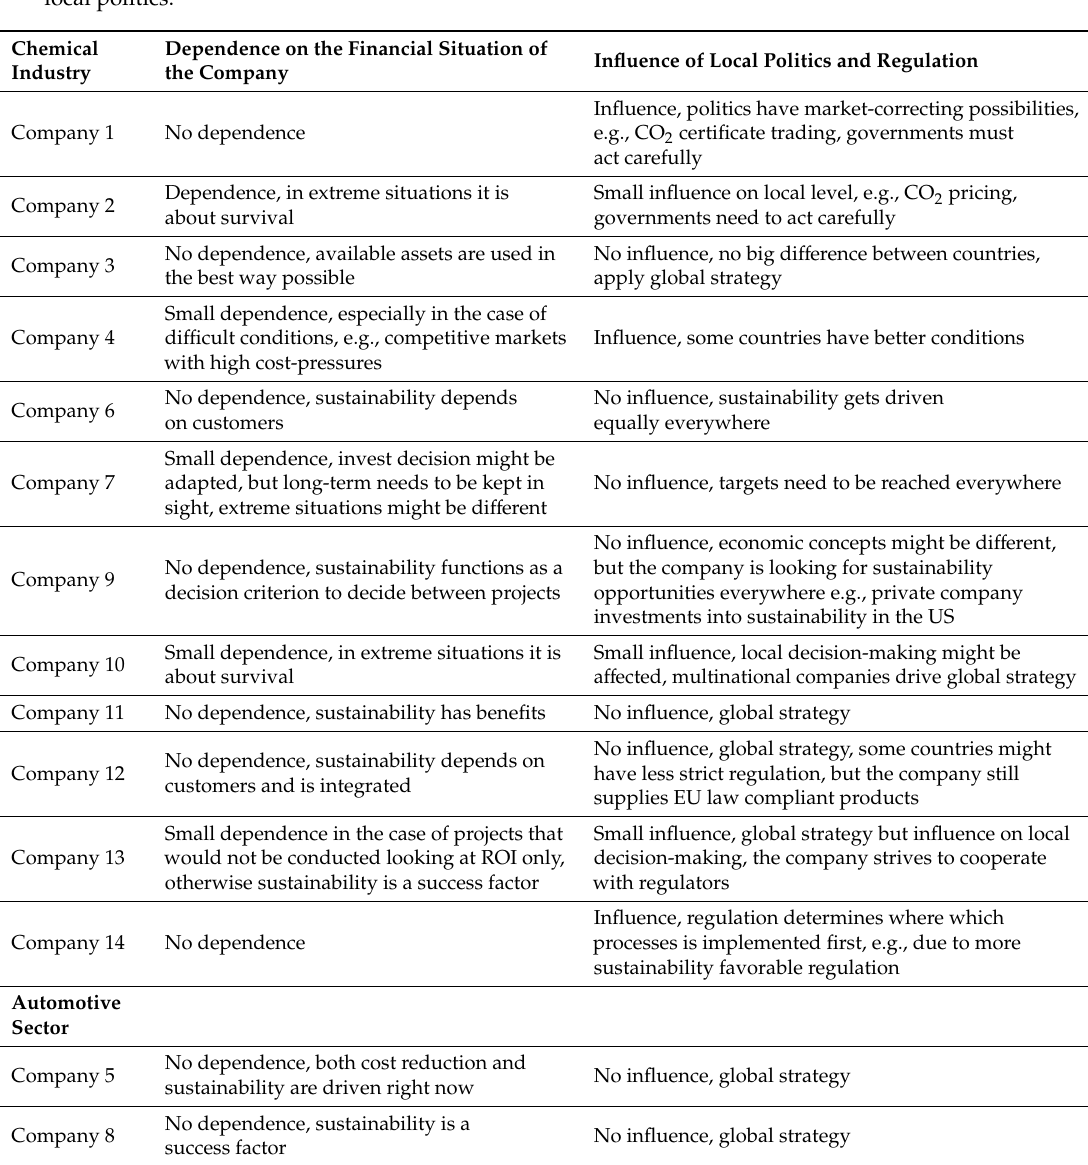
Table 5. Company views on sustainability dependence on financial situation and influence of local